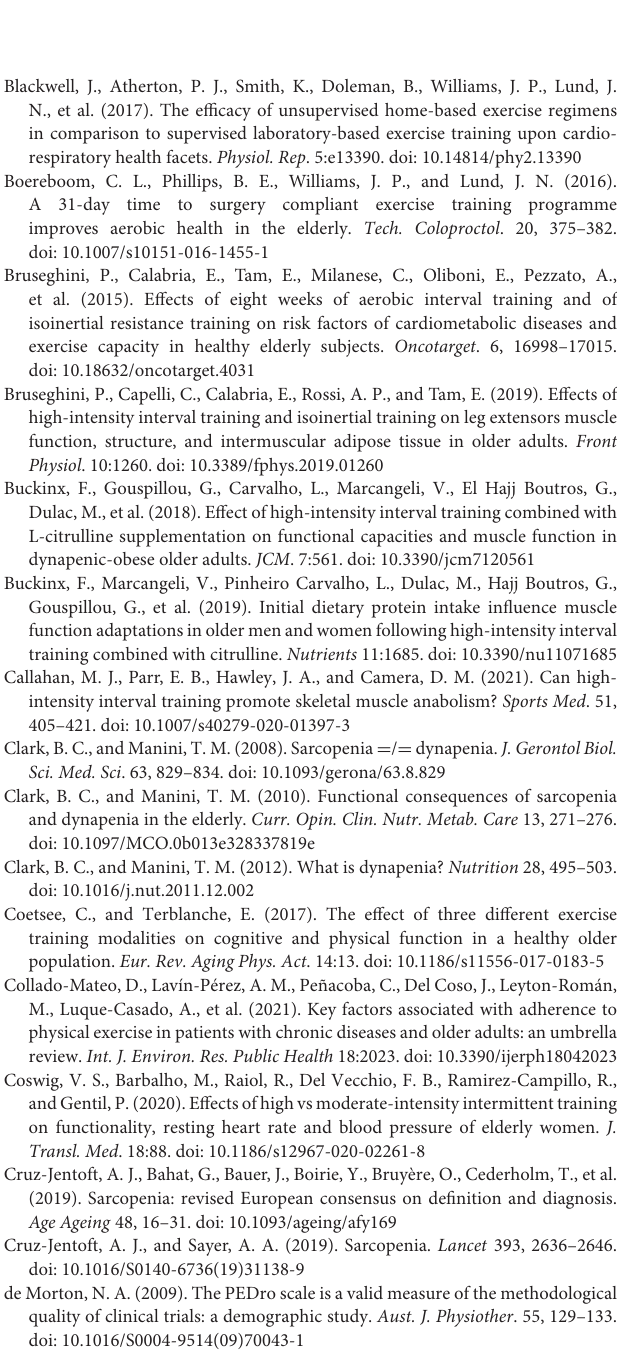
Supplementary Figure 1 | Percent change ( 1 %) in outcome measures for muscle function (a) 5 s chair stand, (b) 30s chair stand, (c) grip strength, muss quality (d) lean mass, or muscle performance (e) timed up and go (TUG), and (f) 6min walk test (6MWT), all as a function of the number of bouts completed. Dashed lines indicate 95% confidence